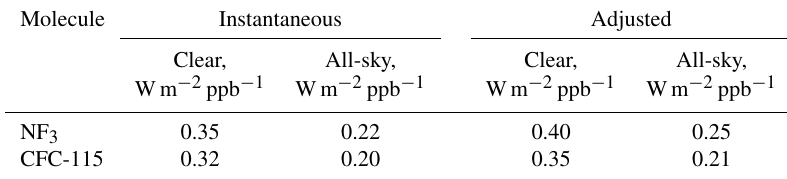
Table 5. Instantaneous and stratosphere-adjusted radiative efficiencies of NF 3 and CFC-115 in clear- and cloudy-sky conditions. Molecule Instantaneous Adjusted Clear, All-sky, Clear,